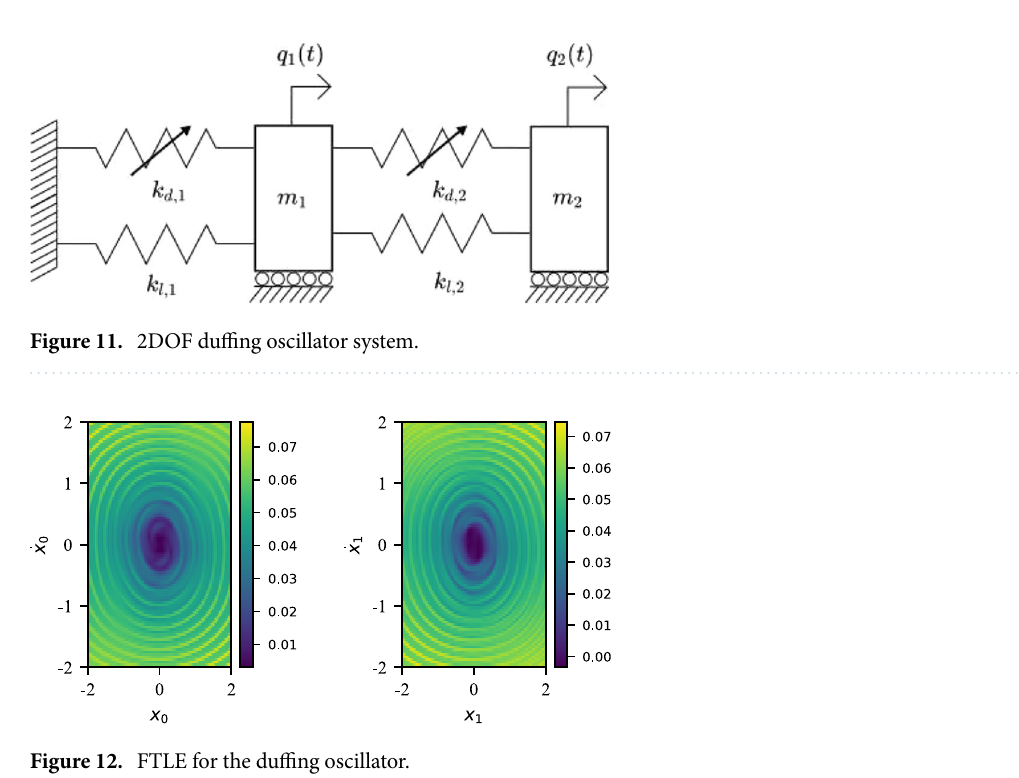
Figure 12. FTLE for the duffing